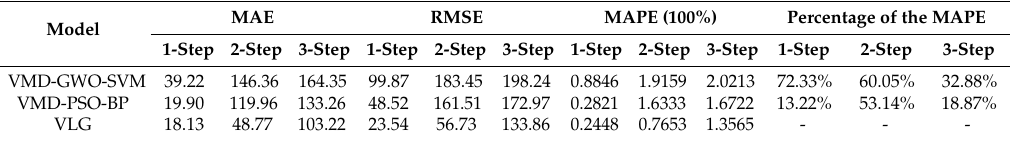
Table 14. Comparison of the forecasting performance of the combined model and that of other VMD-based